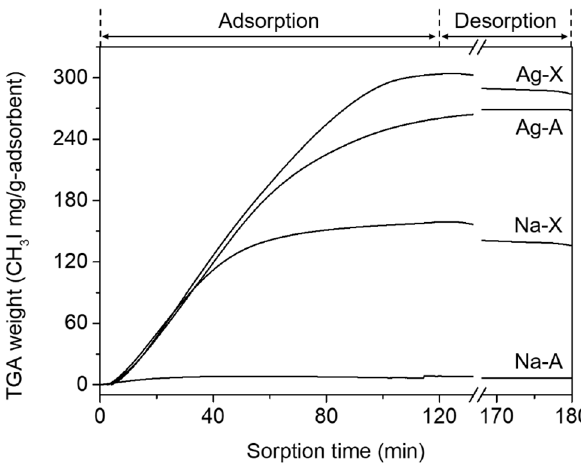
Figure 6. Weight change determined by TGA as a function of time during the adsorption and desorption of CH 3 I on Na-A, Ag-A, Na-X, and Ag-X at 100 °C.